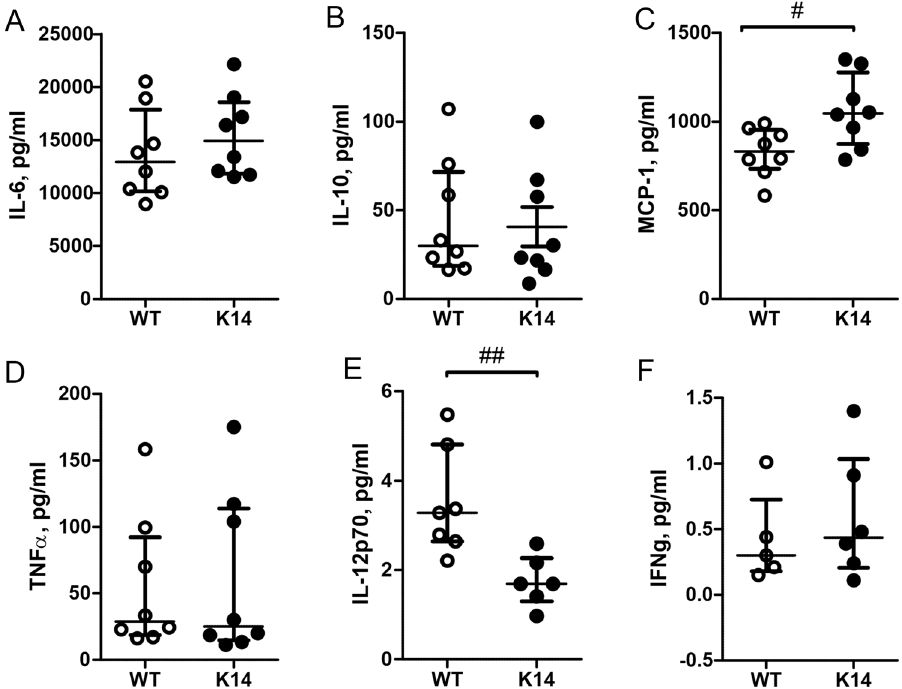
Figure 2. Basal cytokines release from meninges in the hemiskull preparation. Concentrations (pg/ml) of following cytokines are presented: IL-6 ( A ), IL-10 ( B ), MCP-1 ( C ), TNFα ( D ), IL-12p70 ( E ) and IFNγ ( F ). In measured cytokines. Number of replicates for IL-6, IL-10, MCP-1 and TNFα: n = 8/experimental group; for IL-12p70: WT n = 7 and K14 n = 6; for IFNγ: WT n = 5 and K14 n = 6. Mann–Whitney U